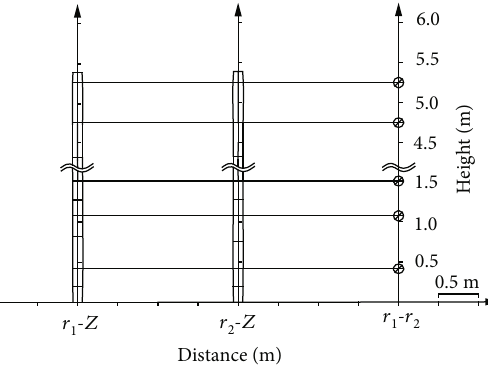
Figure 7: 68-08# hole section (drilling without hydraulic fl ushing).